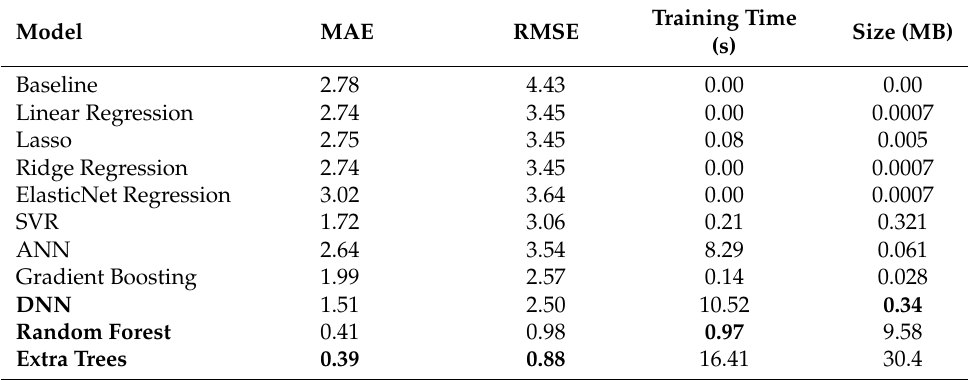
Figure 8. Comparison of machine learning techniques in terms of the MAE and RMSE for FEAT1. Table 3. Comparison of the machine learning techniques for